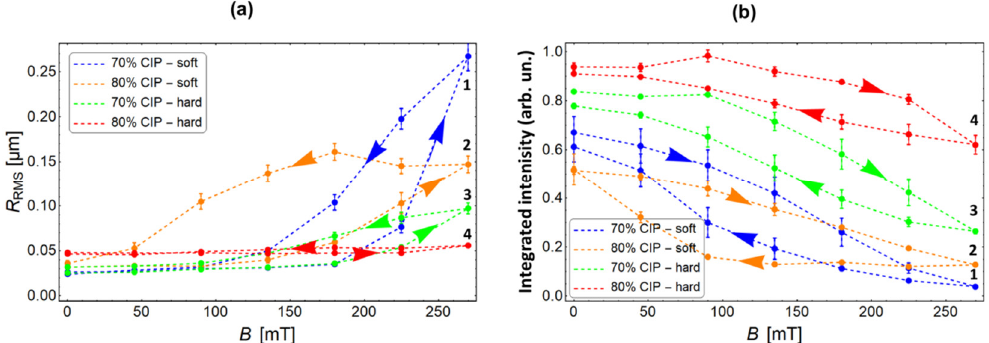
Figure 6. Field dependences of ( a ) the RMS roughness and ( b ) the integrated intensity for four different MAE materials: (blue, 1) soft MAE with a 70 wt% of CIP, (yellow, 2) soft MAE with an 80 wt% of CIP, (green, 3) hard MAE with a 70 wt% of CIP, and (red, 4) hard MAE with an 80 wt% of CIP. The dashed lines are guides to the eye. The arrows pointing to the right indicate data obtained during an increasing magnetic field, and the arrows pointing to the left are data obtained during a decreasing magnetic field.